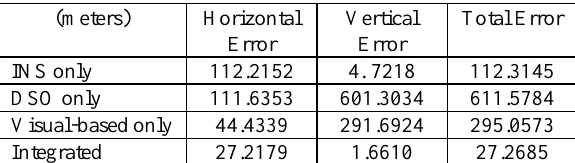
Figure 20. Position error of INS on the three axes